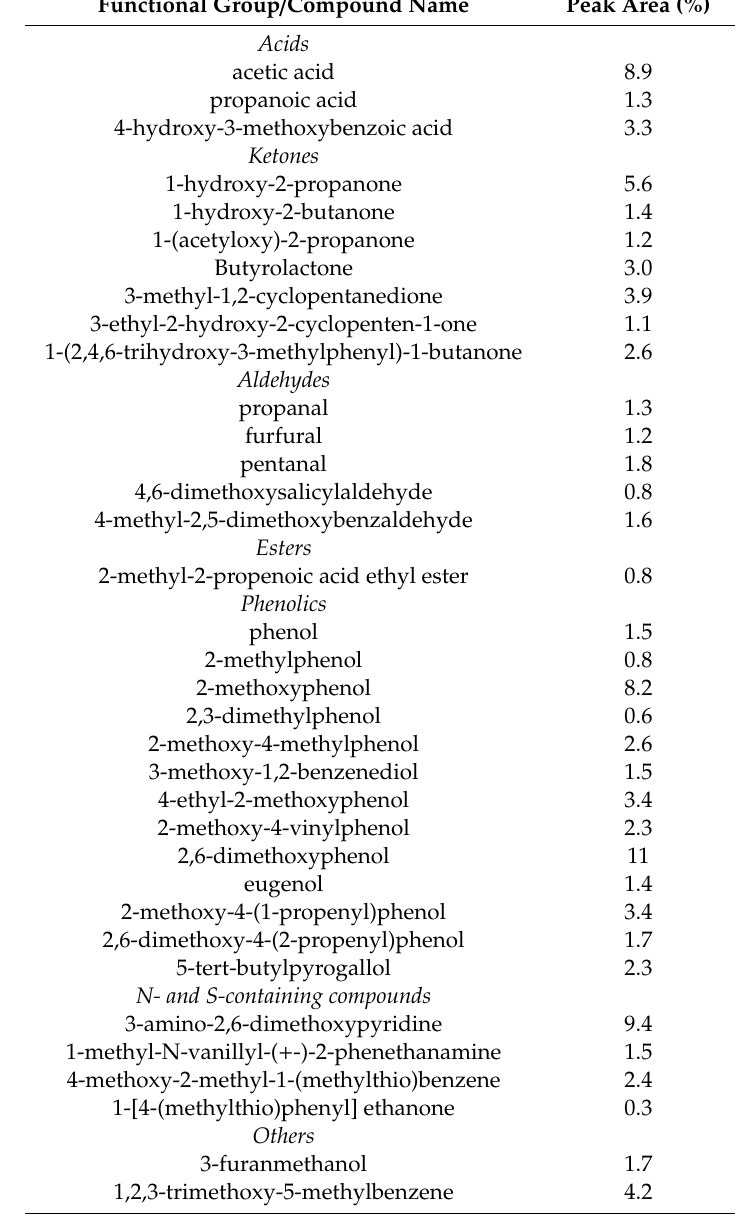
Table 5. GC detectables in the bio-oil obtained from pigeon pea wood pyrolysis at optimized conditions (semi-quantitative analysis by